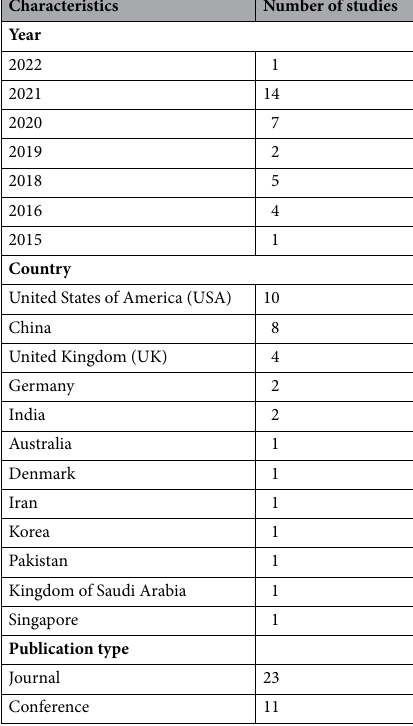
Table 2. Demographics of the included studies.